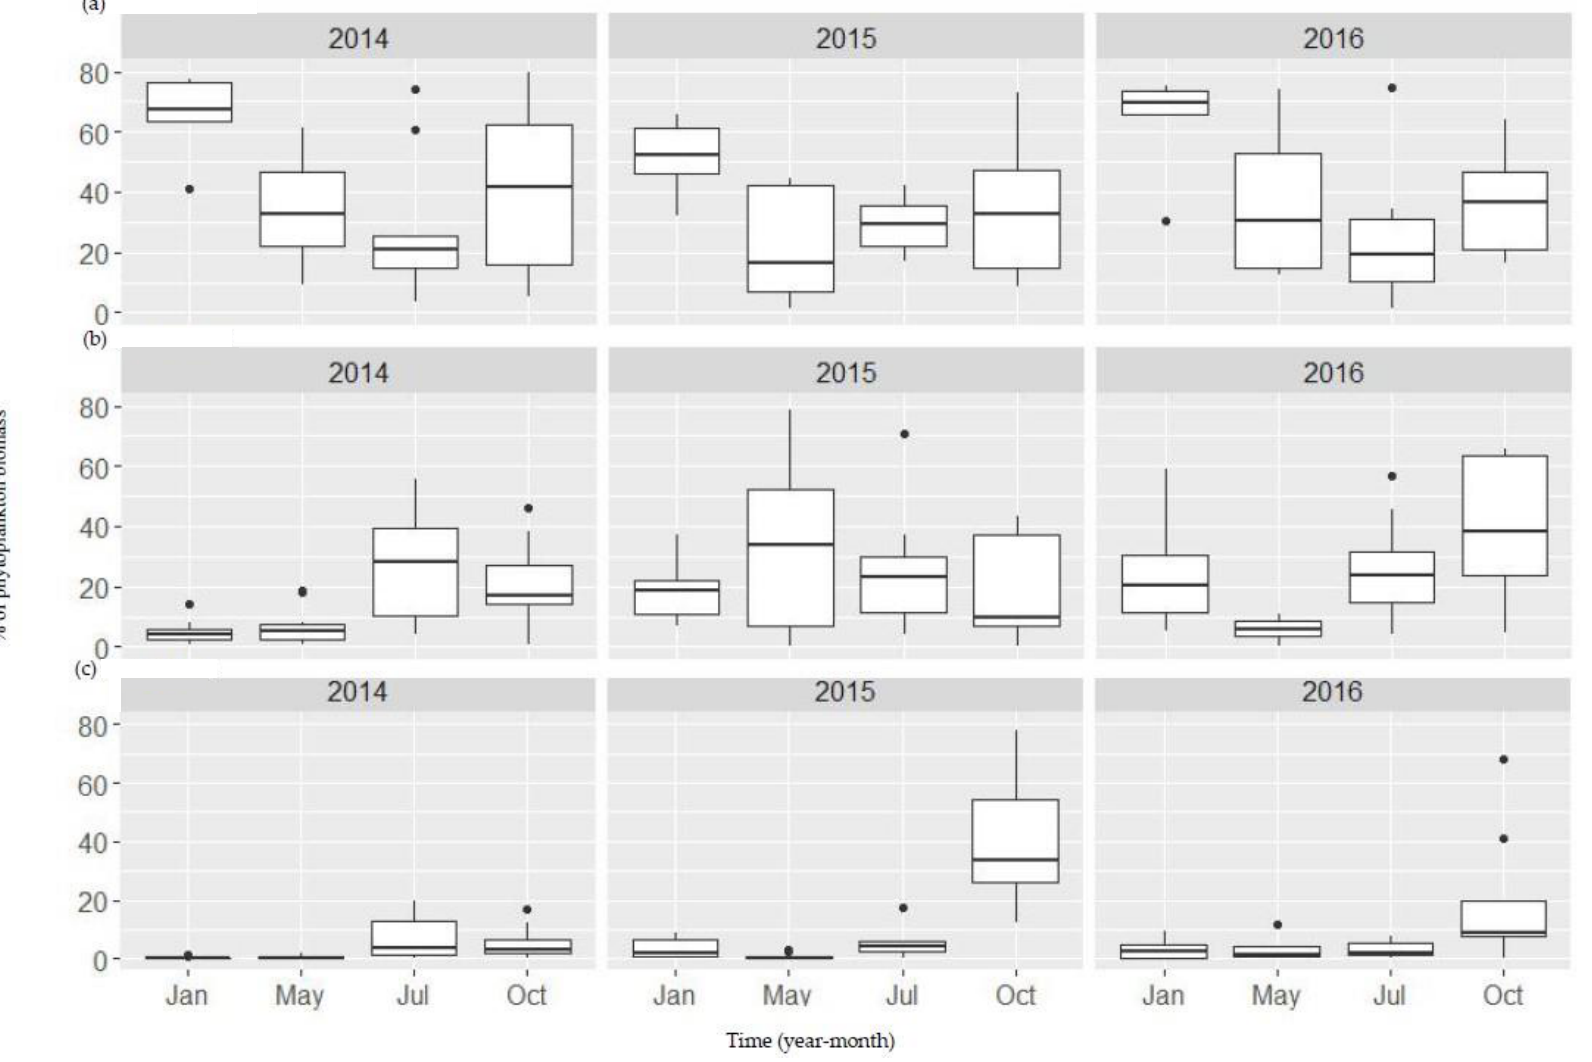
Figure A3. Boxplots showing both temporal and spatial variation of bacillariophyta ( a ), chlorophyta ( b ), and cyanophyt ( c ) between 2014 and 2016 in the Danjiangkou